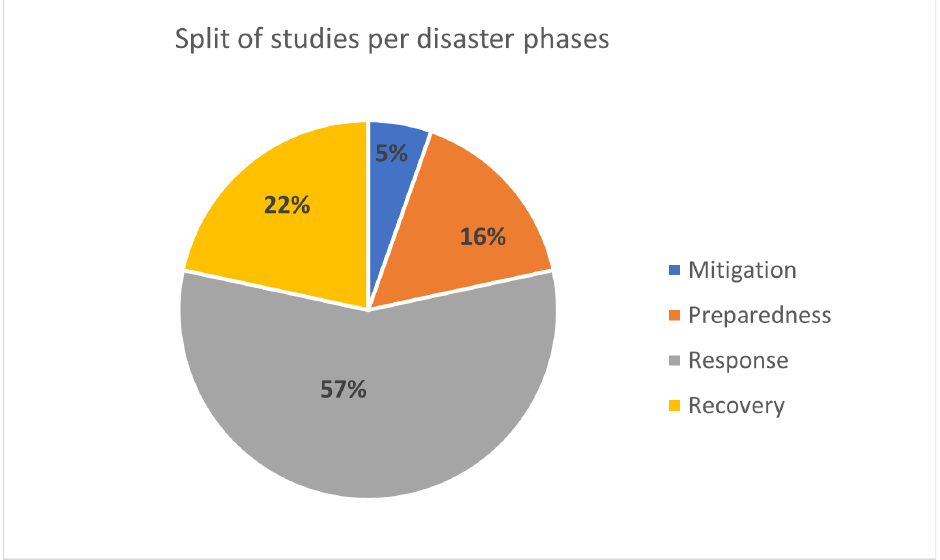
Figure 10. Split of studies per targeted disaster cycle